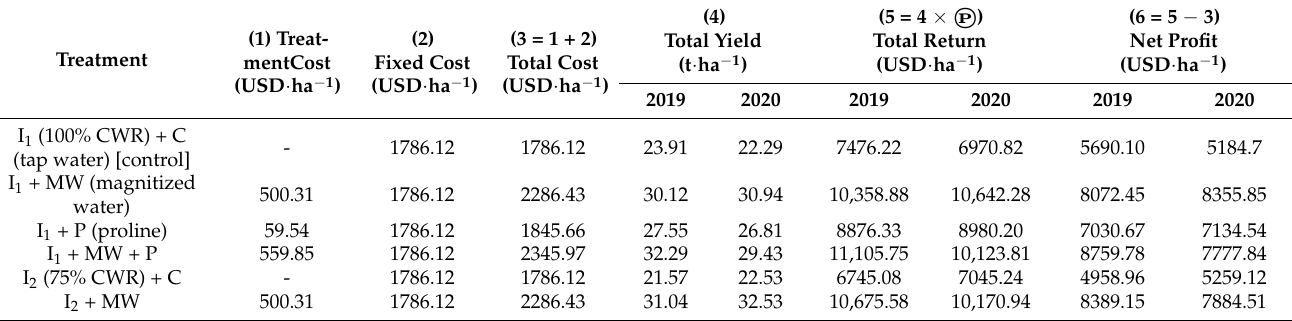
Table 9. The feasibility study of the applied